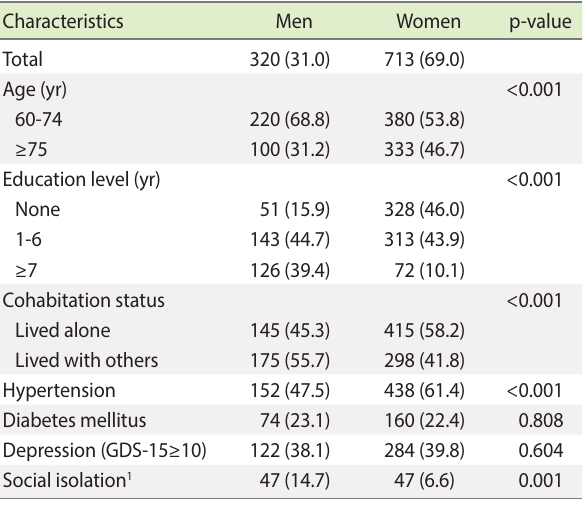
Table 1. Baseline socio-demographic characteristics and health sta- tus of participants (n=1,033)